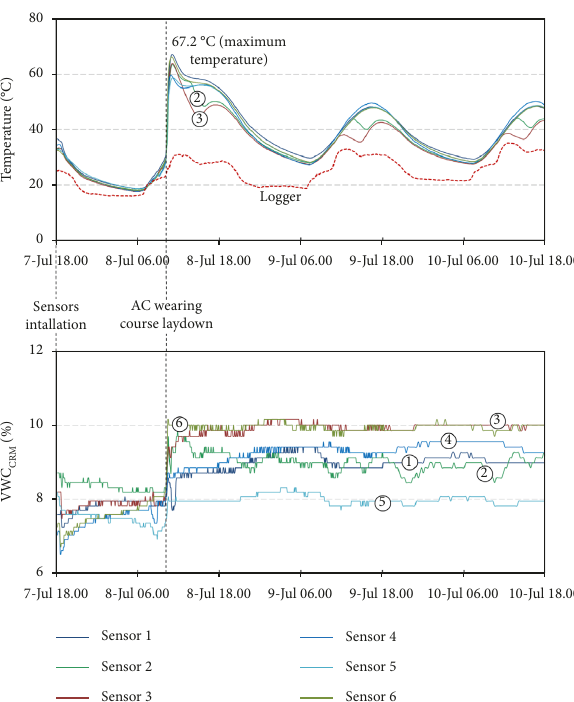
Figure 14: Moisture and temperature variation during the first three days.